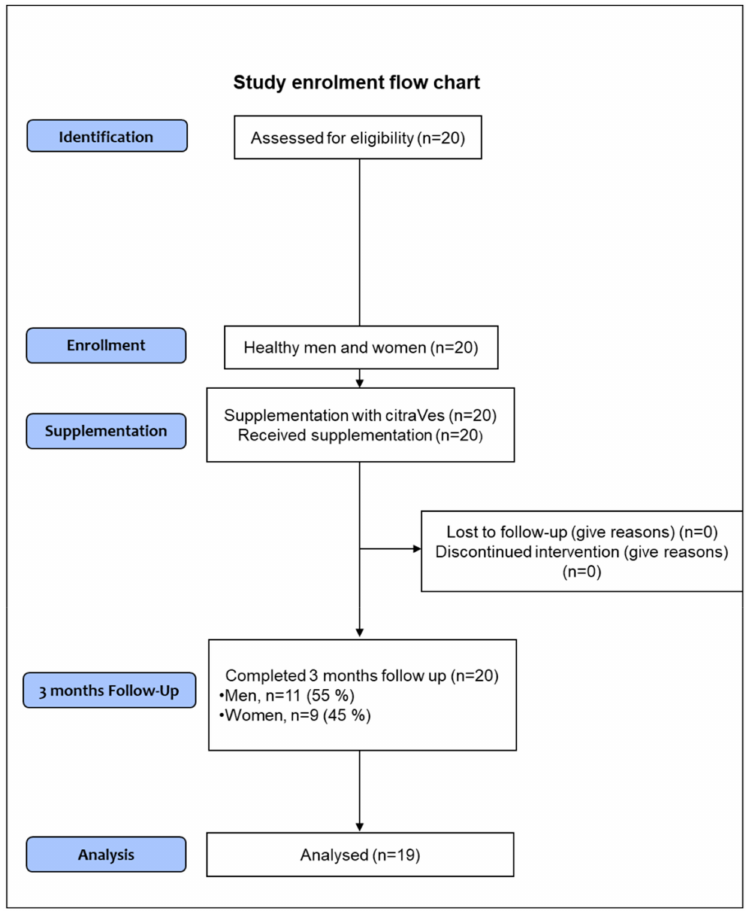
Figure 2. Flowchart of the study enrollment process. Due to the slightly, although not clinically significant, increase in values of waist circumference, triglycerides levels, and blood pressure during the follow-up period, one screened subject was excluded from